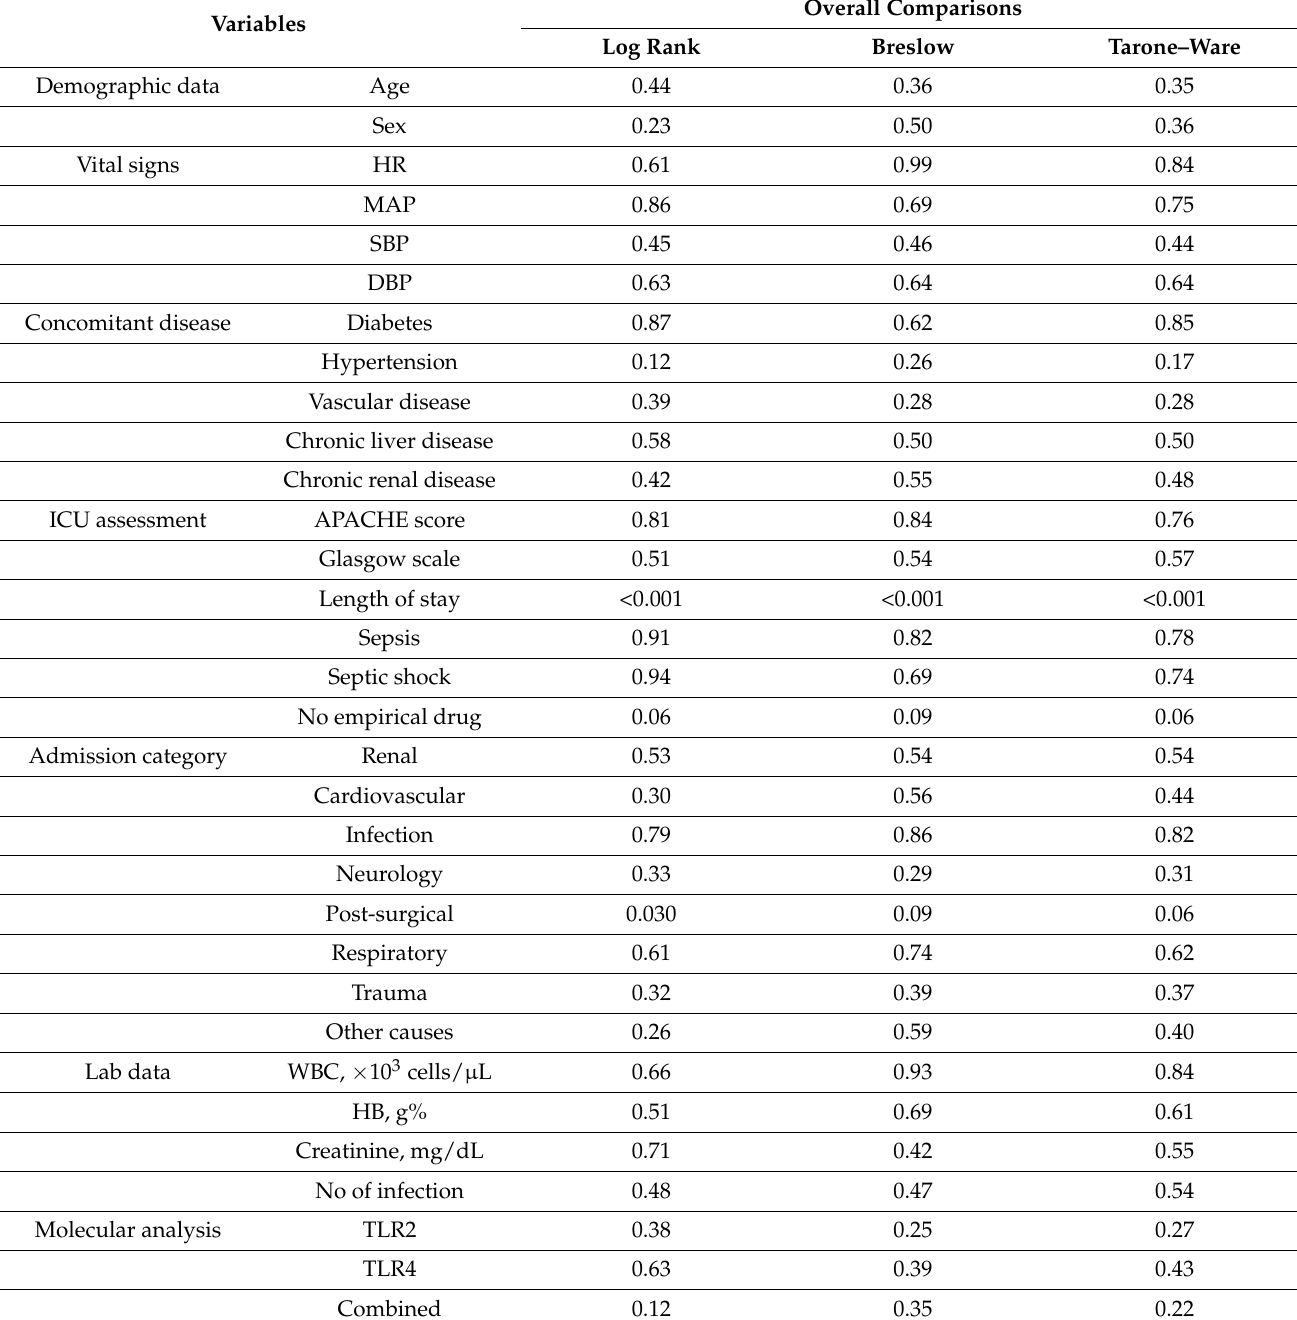
Table 7. Survival analysis in ICU-admitted